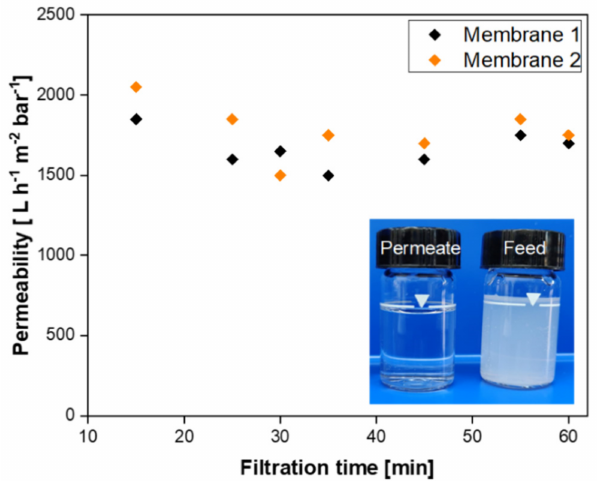
Figure 12. Duplicated permeability values as a function of filtration time for SiC